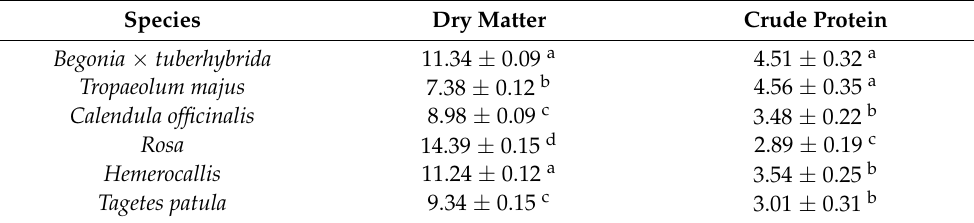
Table 6. Dry matter and the content of crude protein in 6 species of edible